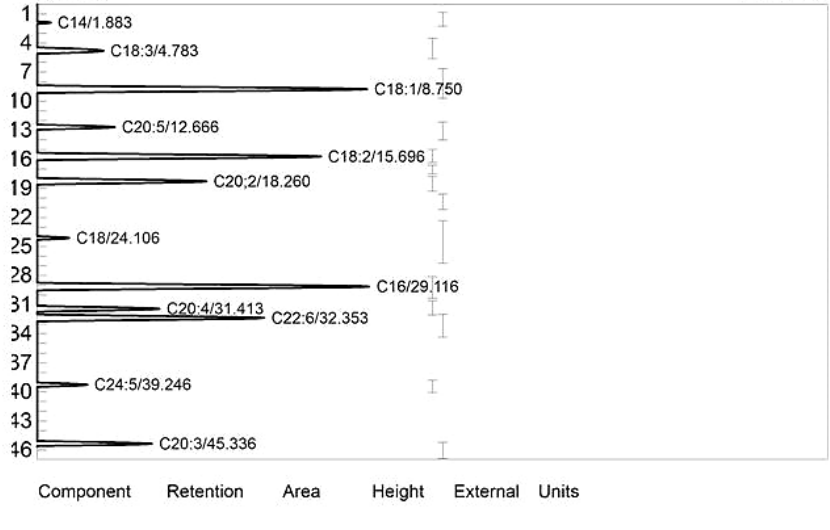
Figure 3. GC-FID spectrum of the produced biodiesel Table 1. Summary of the fatty acid profile of the bio-oil